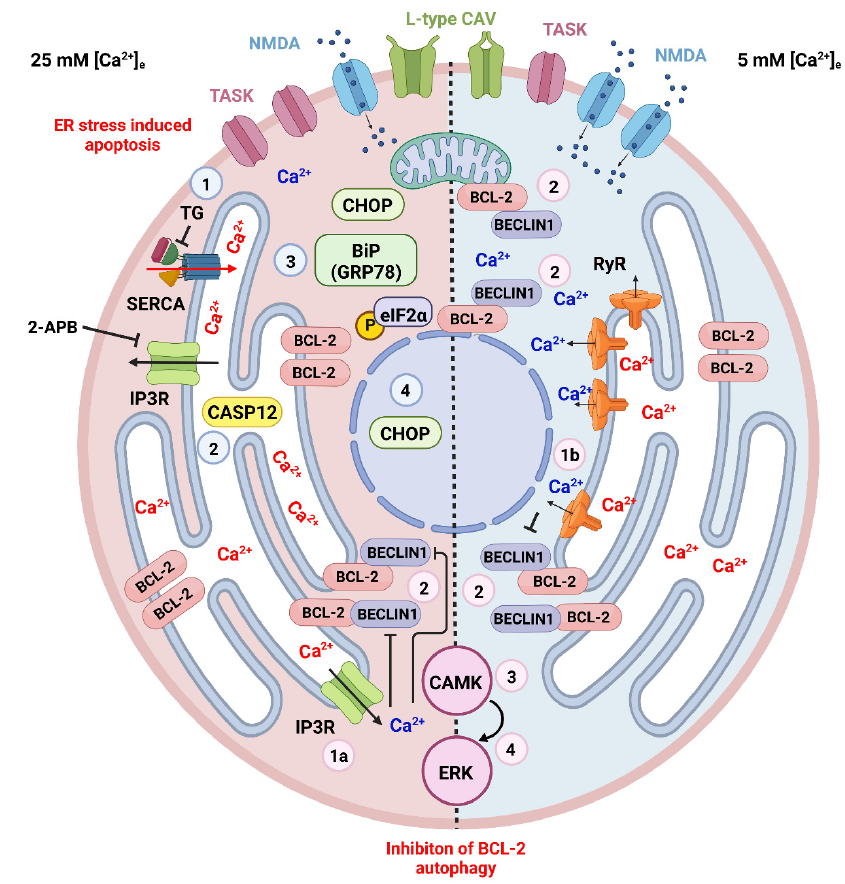
Figure 3. ER stress and cell death in the CGCs. Apoptotic and autophagic mechanisms are dependent on the cytosolic and ER intraluminal concentration of Ca 2+ . These, in turn, are related to the culture conditions in high (on the left represented with pink cytoplasm) or physiological (on the right represented with azure cytoplasm) extracellular K + . Different cultural conditions lead to distinct patterns of expression of plasmalemmal receptors, particularly TASK channels that contribute to the resting membrane potential, L-type Ca 2+ channels that were demonstrated to interact with RyRs in CGCs [232], and NMDA glutamate receptors. Several drugs have been used to induce ER stress in CGCs (see the main text) cultured in 25 mM [K + ] e eventually leading to apoptosis. The figure shows the cellular events following thapsigargin (TG—numbered azure circles), a blocker of SERCA. With SERCA block, the influx of Ca 2+ into the ER lumen stops, leading to the activation of CASP12 and the expression of the UPR molecules BiP(GRP78), phosphorylated eIF2 α and CHOP, the latter eventually being translocated to the nucleus and promoting the transcription of proapoptotic genes. ER Ca 2+ controls cellular homeostasis through two different mechanisms mediated by IP3Rs (1a—pink circle) or RyRs (1b—pink circle). The outflow of Ca 2+ from the ER leads to an increase in the cytoplasmic concentration of the ion with the phosphorylation of BCL-2 and its dissociation from beclin1, thereby inhibiting BCL-2 autophagy through the activation of the CAMK-ERK pathway (pink circles 2–4) [128]. This mechanism operates in both high and physiological [K + ] e . Created with Biorender.com (www.biorender.com, accessed on 27 November